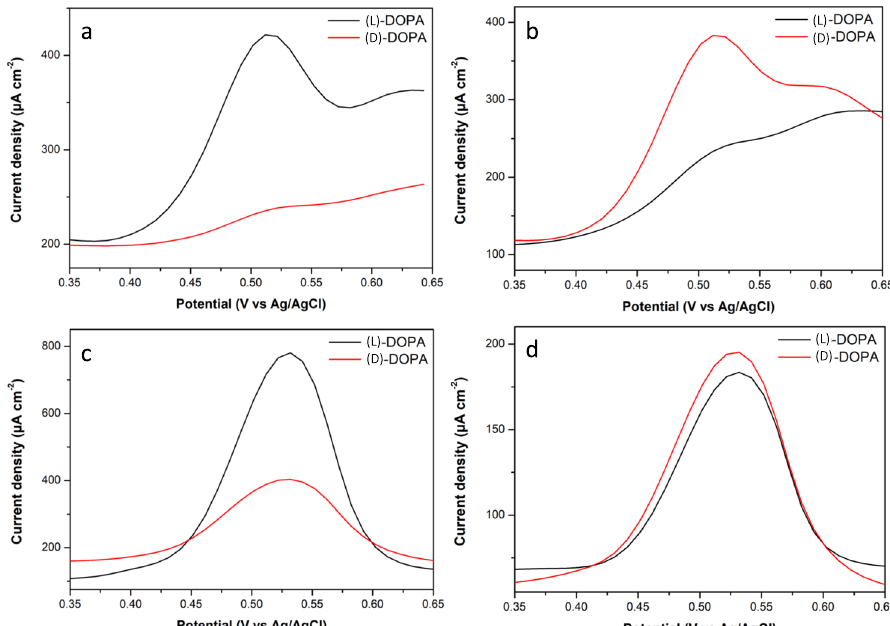
Fig. 4 Enantioselective detection. Differential pulsed voltammograms (DPVs) of (L)-DOPA (black) and (D)-DOPA (red) electrooxidation recorded with different Pt-Ir electrodes: a , b Signals recorded for fresh (L)-DOPA and (D)-DOPA-imprinted mesoporous Pt-Ir alloys, respectively. DOPA electrooxidation on (L)-DOPA-imprinted mesoporous Pt-Ir alloys after trying to erase the chiral information by cycling the potential in 0.5 M H 2 SO 4 for: c 10 cycles in the range from − 0.20 to 1.20 V vs. Ag/AgCl, and d 40 cycles from − 0.20 to 1.80 V vs. Ag/AgCl. All experiments were performed in 4 mM (L)- or (D)-DOPA in 50 mM HCl solution as supporting electrolyte (pH = 1.4) with electrodes synthesized with a deposition charge density of 6 C cm − 2